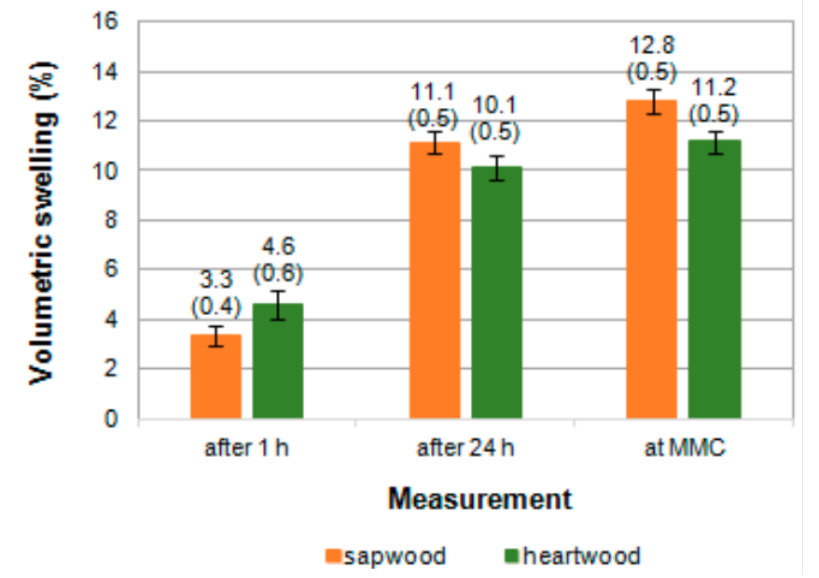
Figure 10. Volumetric swelling (VS) of the sapwood and heartwood of oriental arborvitae; ±